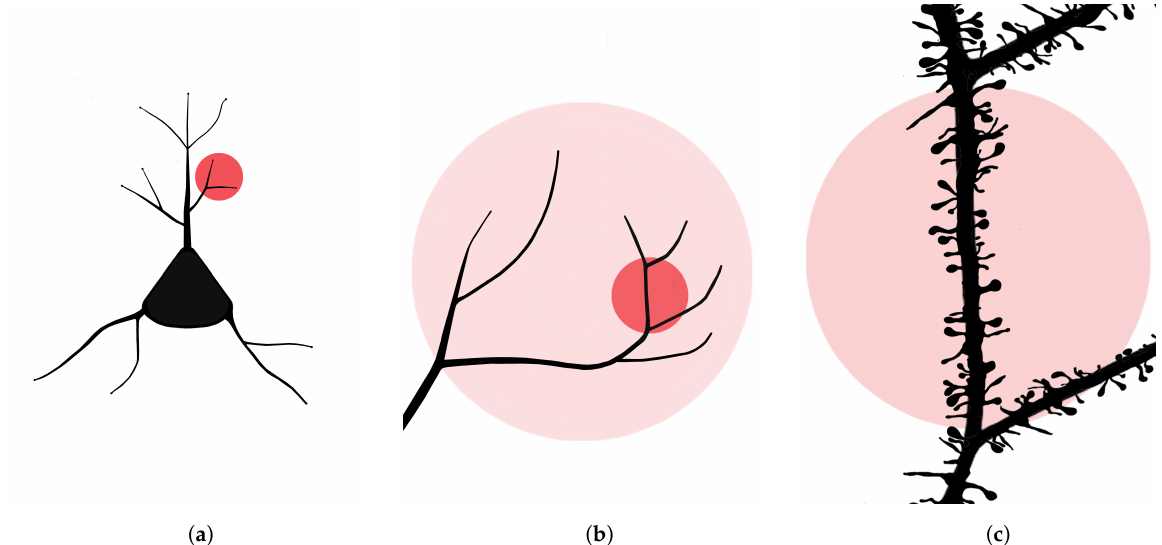
Figure 1. Sequence of navigation steps for selecting an area of interest within a specific neuron. ( a ) Iconic representation of a neuron; ( b ) Id. for a dendrite; ( c ) Full details from a dendrite